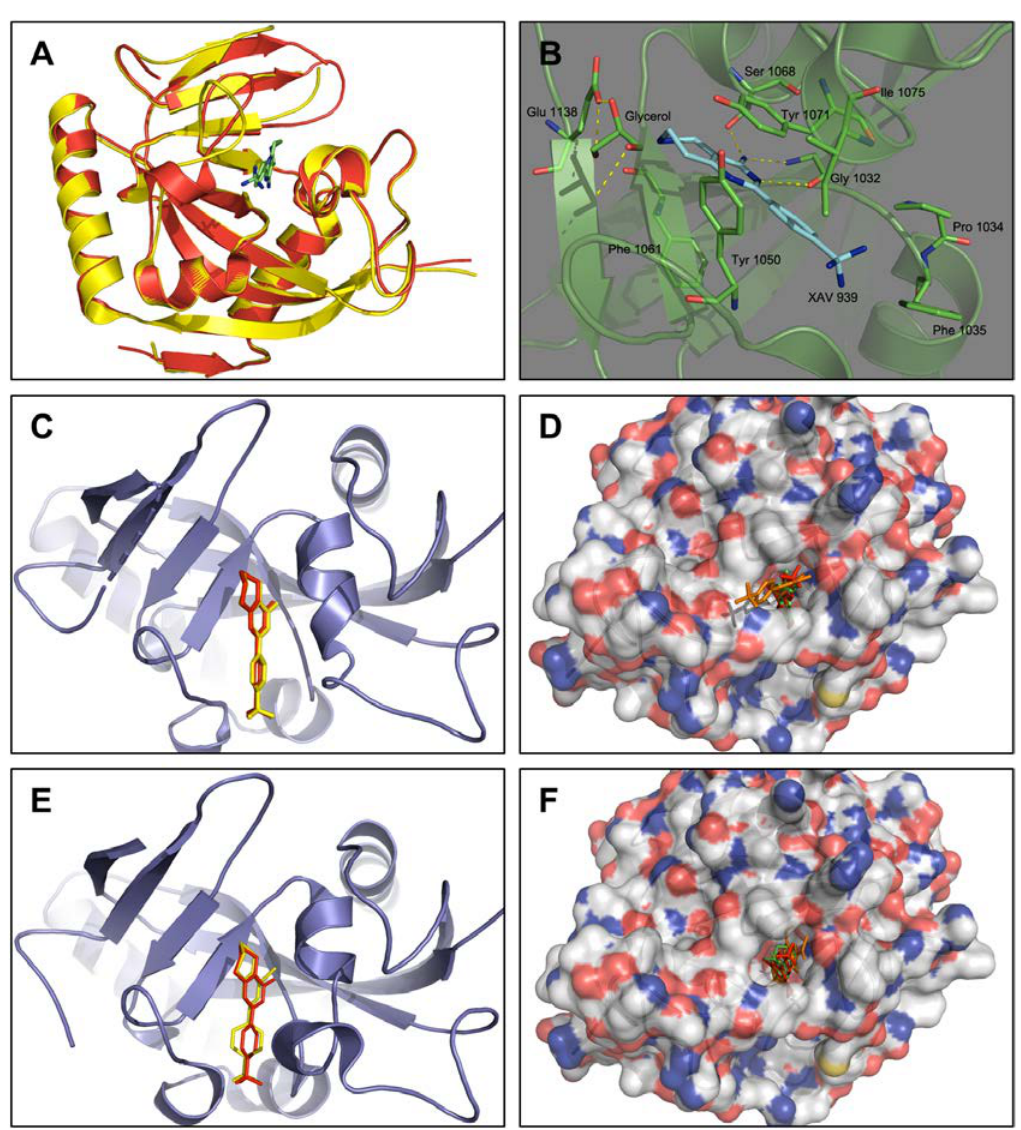
Figure 1. Identify binding site and evaluate docking program. ( A ): comparison of crystal structure of TNKS-1 (yellow, 2RF5) and TNKS-2 (red, 3KR8), XAV939 shows its original location in co-crystal with TNKS-2 (green). ( B ): Several amino acids were involved in the interaction with XAV939 in the active site pocket of TNKS-2, hydrogen bonds are represented by dashed lines. ( C ): XAV939 were re-docked back into the active site of TNKS-2 (red) by DOCK6.5 and the pose of XAV939 were at the original position in co-crystal (yellow). ( D ): XAV939 (red), ABT-888 (green), LDW643 (orange) were docked into the same activated pocket in TNKS-2 by DOCK6.5 . ( E ): XAV939 were re-docked by Autodock4.2 (red) and the pose of XAV939 were original position in co-crystal (yellow). ( F ): XAV939 (red), ABT-888 (green), LDW643 (orange) were docked in TNKS-2 by Autodock4.2 . All graphical pictures were generated using the PyMol program (http://www.pymol.org/).